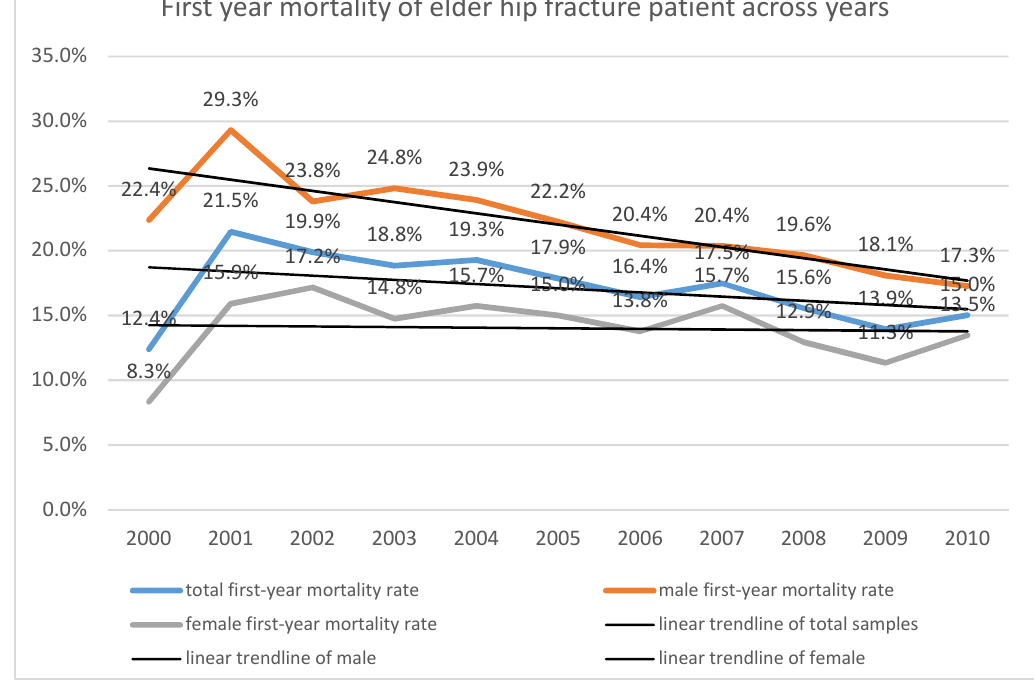
Figure 3. First year mortality of elder hip fracture patient across years.